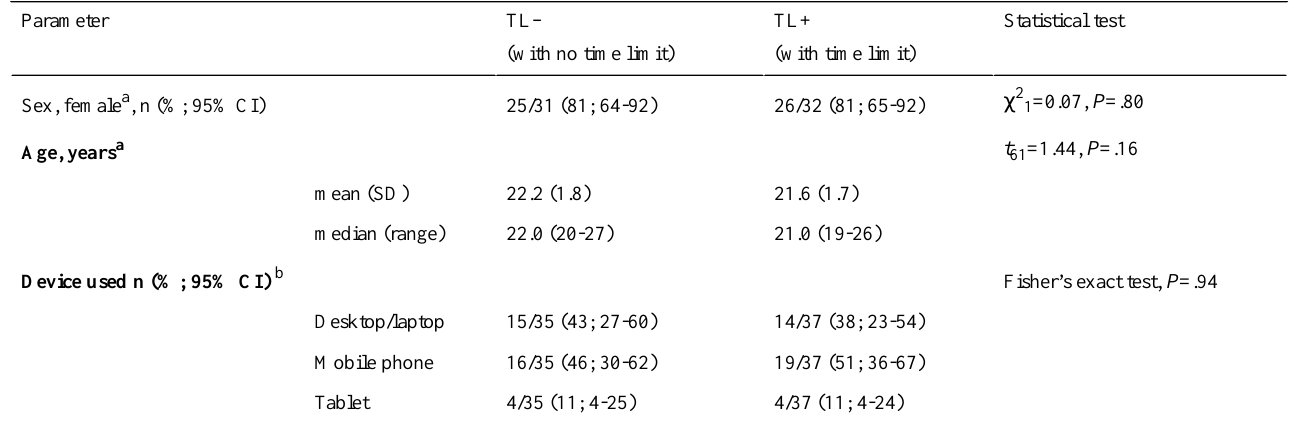
Table 1. Sex, age, and devices used by study participants.